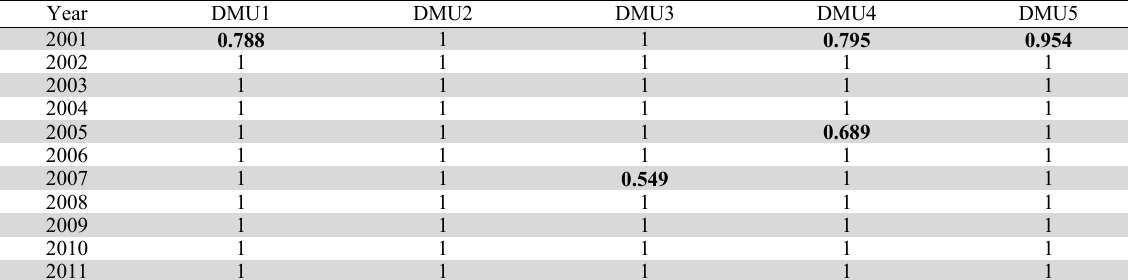
Efficiencies of